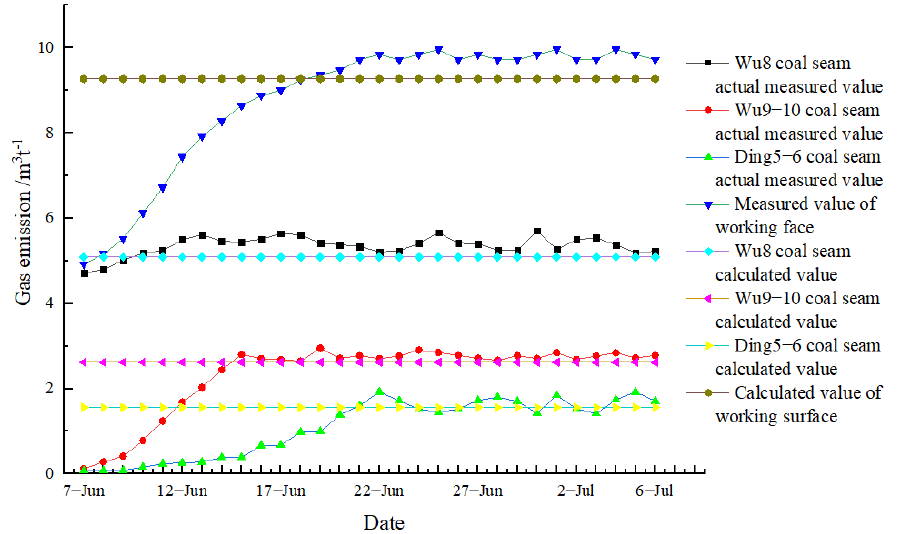
Figure 7. Variation trend of measured and calculated values of gas emission.